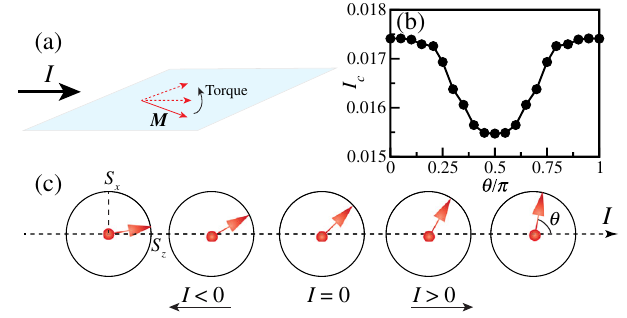
FIG. 6. (a) The TB layer contains magnetic order M . The current I induces the magnetic direction rotation through a spin-orbit torque. (b) The critical current I c in unit of 2 e= ℏ as a function of θ the angle of the internal magnetization with respect to the z axis. This I c anisotropy is owing to SOC. Here, the magnitude of the magnetization is fixed to M 0 ¼ 0 . 2 so that ¼ M θ and M ¼ M θ . The other parameters are set M z 0 cos x 0 sin ¼ t ¼ 1 . 0 , α ¼ 0 . 2 , and as t R ¼ t L ¼ 1 . 0 , Δ 1 ¼ Δ 2 ¼ 0 . 2 , t RB LB μ ¼ − 3 . 0 . In the calculation, we set the thickness of SC on both sides to be 20 and the thickness of the TB to be 5. (c) A schematic plot of the current induced JD process. In positive direction, θ increases toward S x , and in negative direction, θ decreases toward S z .